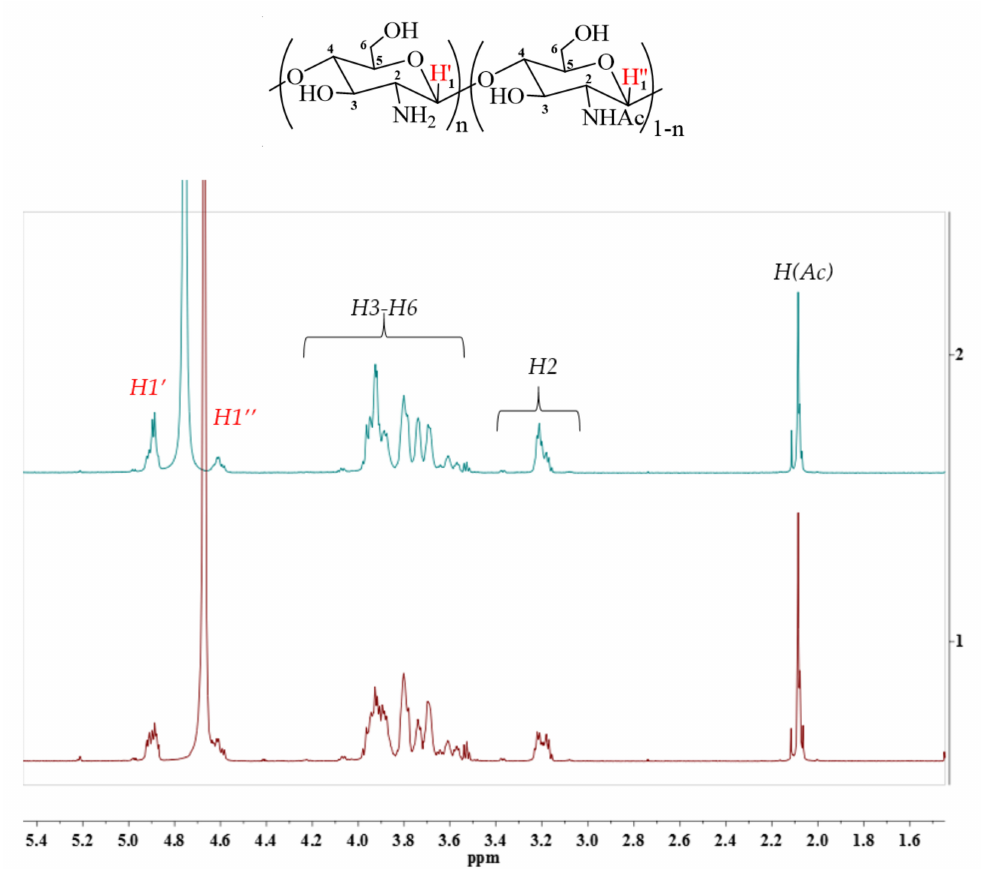
Figure 4. 1 H NMR spectra of depolymerised chitosans obtained from H. illucens (6.86 kDa) ( 2 ) and crab (6.78 kDa) ( 1 ).